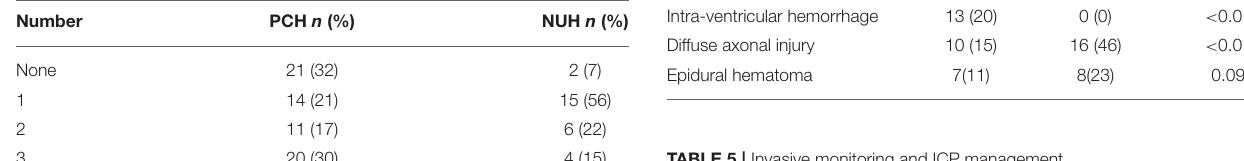
TABLE 5 | Invasive monitoring and ICP